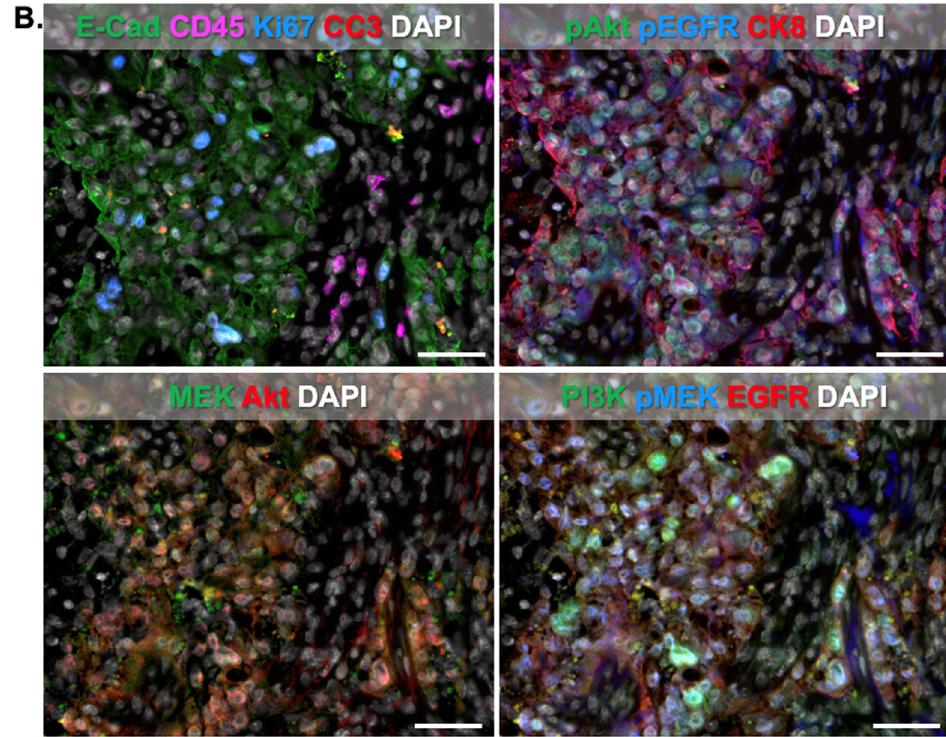
Figure 8. Highly multiplexed flexible cyCIF. ( A ) Indirect IF was combined with Ab-oligo cyCIF using 2 × PCL-FL and amplification strategies followed by a final round of direct IF staining to generate a 12-color image on the frozen HCC827 xenografts. ( B ) A representative region of interest is shown to demonstrate that these strategies can be readily combined to generate spatial proteomic data. Scale bar = 50 µ